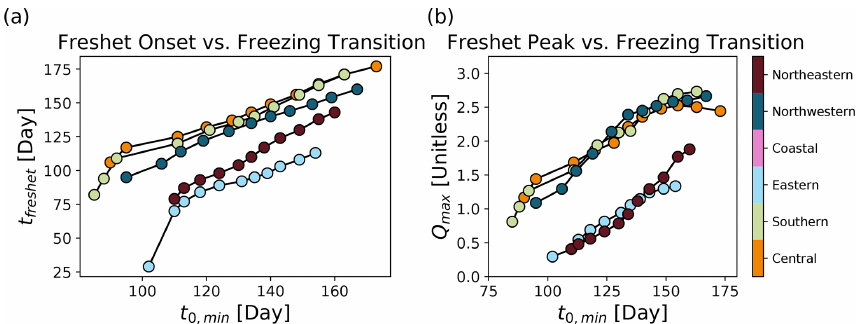
Figure 10. Modelled (a) freshet timing indicator and (b) peak magnitude are both positively correlated with the day that minimum tempera- tures rise above freezing. The coastal cluster is not shown as it is dominated by winter rainfall rather than a spring freshet.